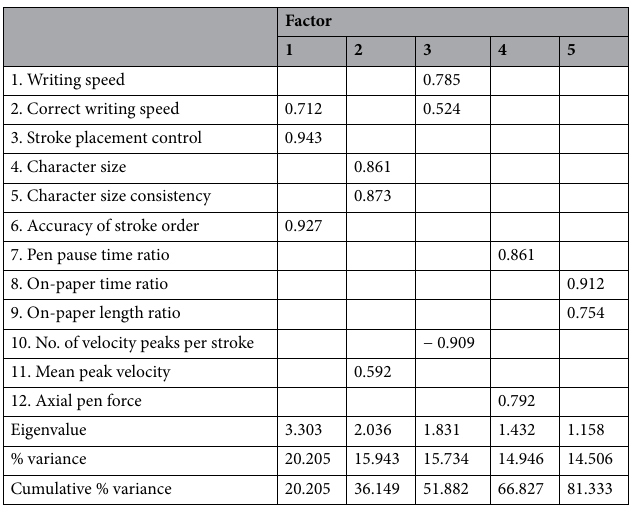
Table 2. Factor analysis: measures and factor loadings (N = 641). Measures with factor loadings larger than 0.50 are listed. % is the variation explained by a single factor. Cumulative % is the variation explained